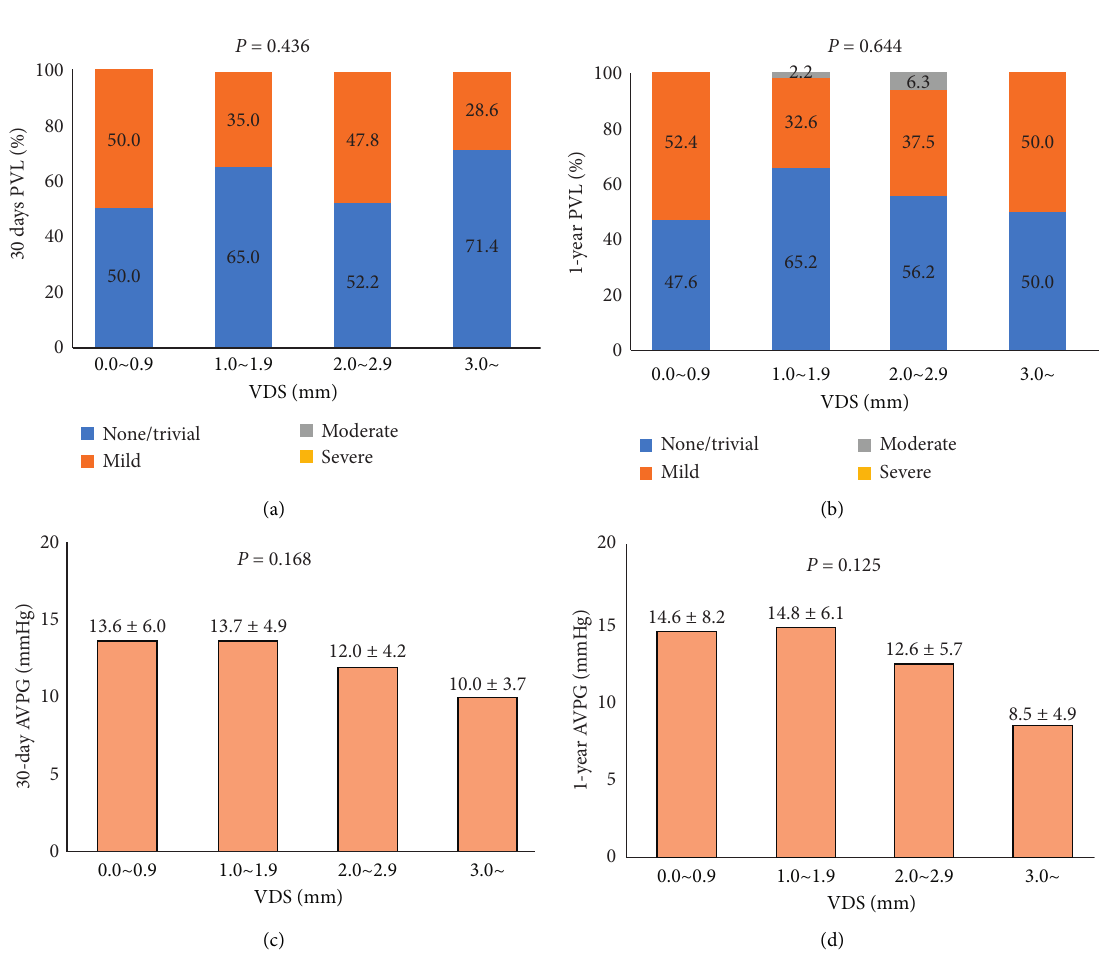
Figure 3: The association of valve distortion score with paravalvular leak and aortic valvular pressure gradient. The degree of valve distortion score (VDS) was not associated with a 30-day paravalvular leak (PVL) (a) and aortic valvular pressure gradient (AVPG) (c). The VDS was also not associated with the degree of PVL (b) and AVPG (d) at 1-year follow-up transthoracic